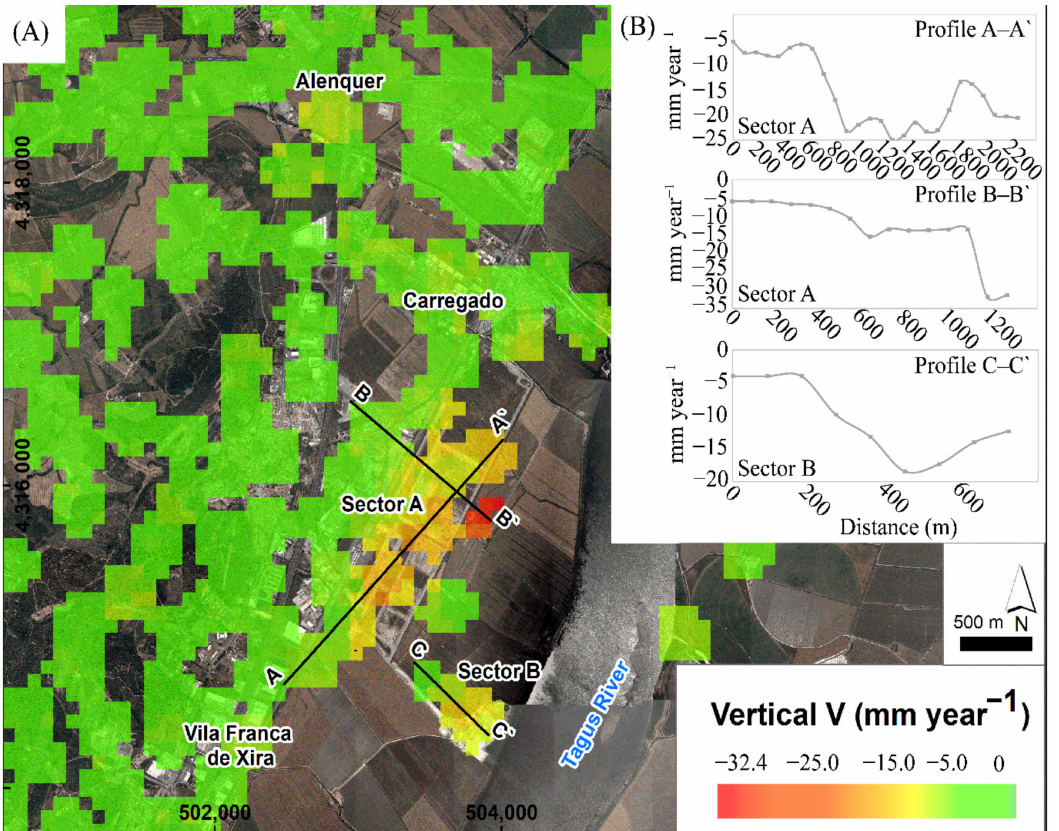
Figure 9. ( A ) Vertical velocity (mm year − 1 ) raster (pixel 90 × 90 m) and location of vertical velocity profiles. ( B ) Profiles of vertical velocity (mm year − 1 ). Ortophoto 2018, with a pixel resolution of 0.25 m, provided by ©Direcç ã o-Geral do Territ ó rio